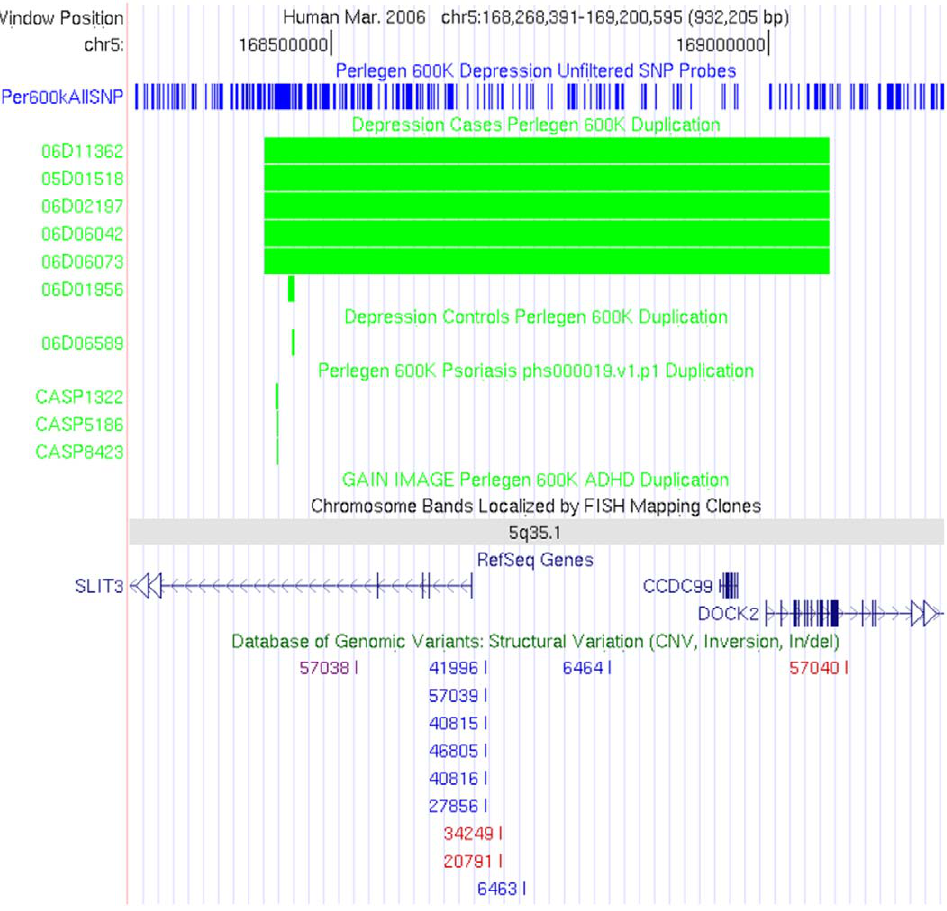
Figure 1. Duplication of 5q35.1 impacting SLIT3 observed in 5 unrelated MDD cases. The coverage of SNPs on the Perlegen 600 K array is shown across the 5q35.1 locus with vertical blue lines. There are 198 SNPs within the duplication call boundaries shown as green rectangles for the 5 MDD cases with sample IDs listed to the left. Depression control, Psoriasis, and ADHD GAIN Perlegen 600 K sample sets are shown to not have CNV calls of the large size observed in MDD cases. All calls generated are shown for completeness of observation. Very small calls of 1.8 kb and less are observed in this region which is dissimilar from the case calls. The genes SLIT3, CCDC99, and DOCK2 are shown to have exons impacted by the duplication. Finally, the Database of Genomic Variants entries are shown which are very small and do not impact